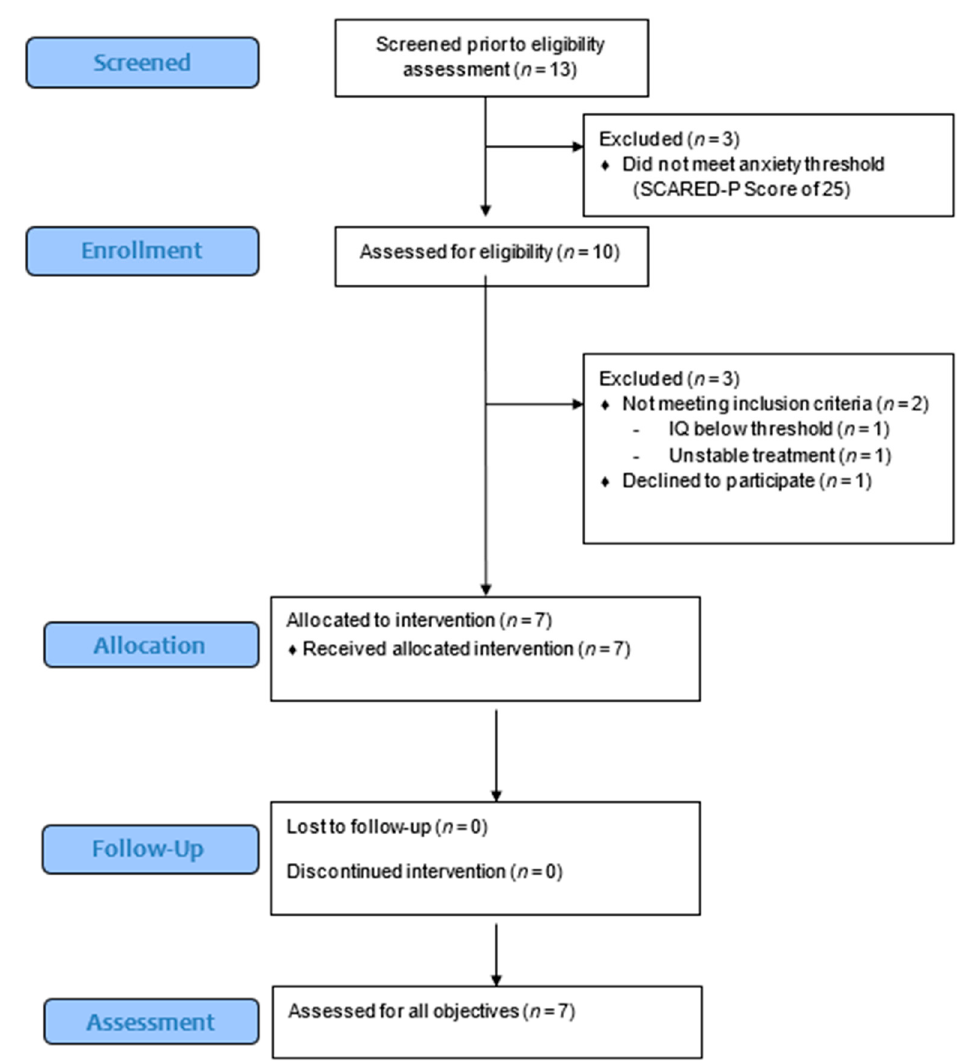
Figure 3. CONSORT flow diagram illustrating the allocation of each subject. Thirteen subjects were screened and 7 underwent treatment and assessment for all objectives.